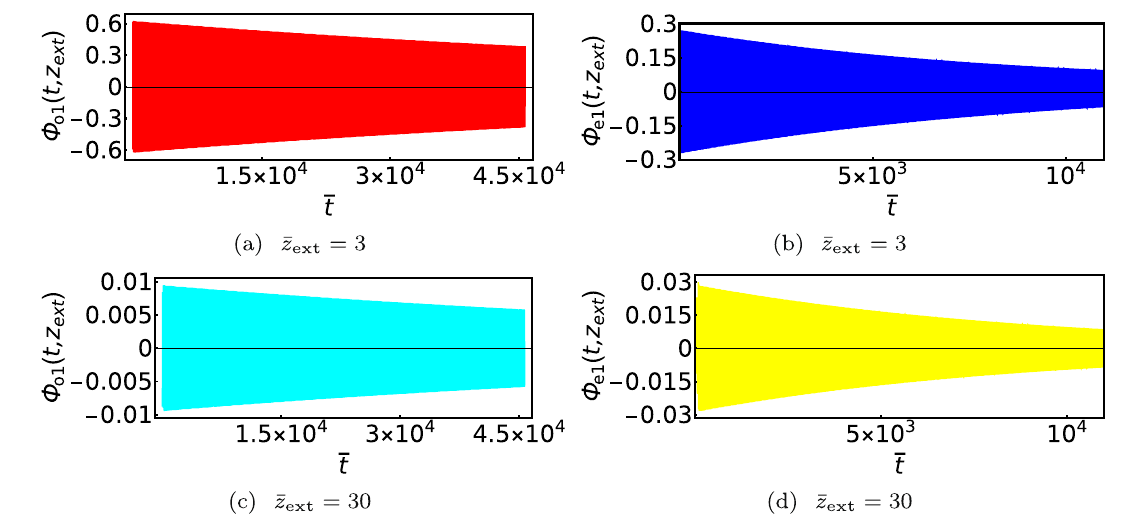
Fig. 4 Upper panel: Time evolution of the first odd resonance (left) and the first even resonance (right) at ¯ z ext = 3 for ¯ b = 15. Lower panel: Time evolution of the first odd resonance (left) and the first even resonance (right) at ¯ z ext = 30 for ¯ b = 15. Here ¯ z ext = kz ext